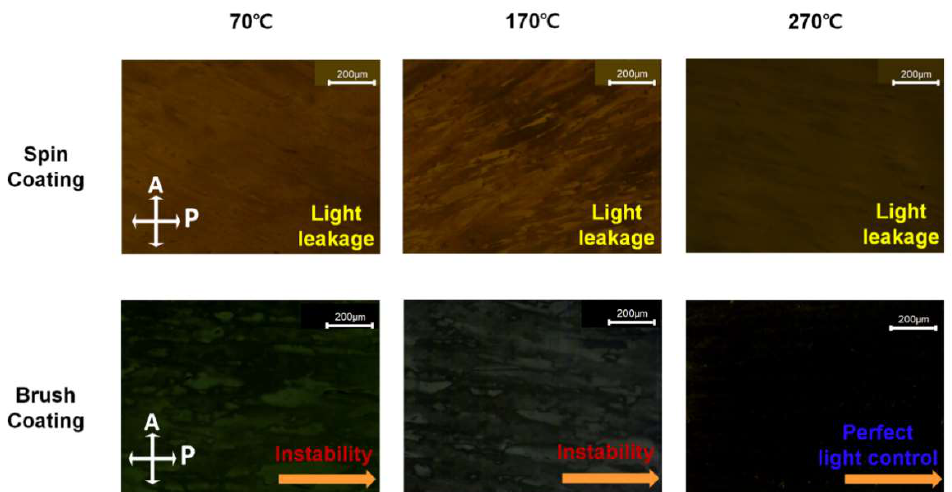
Figure 5. POM results of the AP-LC cells fabricated by spin-coated and brush-coated LaYSrO layers cured at 70, 170, and 270 °C. The analyzer (A) and polarizer (P) are denoted by white arrows. The brush-coating direction is represented by thick orange arrow.